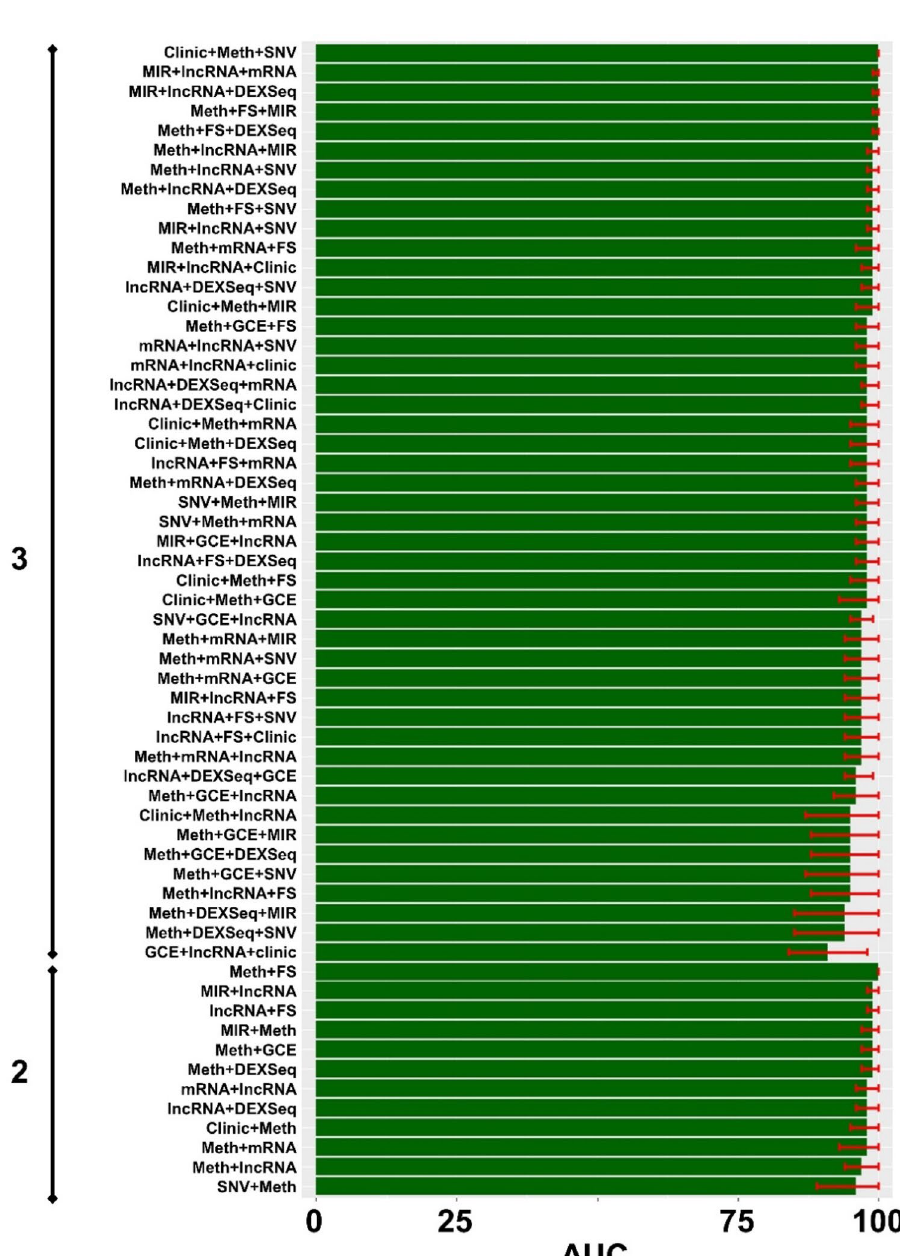
account for some variation in the validation of these prediction models of treatment response, except for those models including DNA methylation and/or lncRNA. The poor performance of validation TCGA prediction models including DNA methylation and/or lncRNA data was likely due to other reasons. DNA methylation analy- sis for TCGA HGSC data was performed using Illumina Infinium HumanMethylation27K BeadChip arrays 47 . Methylation in UI was performed with an EPIC BeadChip 850 k arrays (both arrays from Illumina Inc.). The 27 K methylation array interrogates mainly CpG islands in gene promoter regions, while the 850 K array also explores DNA methylation outside the promoter areas with whole genome coverage 32 . To determine lncRNA